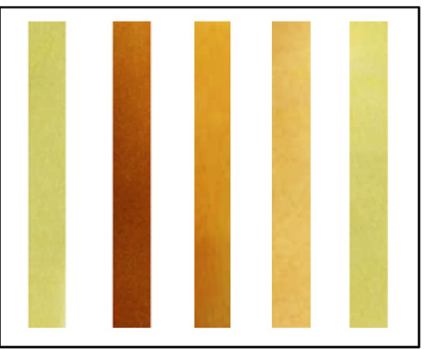
Figure 9. Color change of the test strips of L4 (1 × 10 −3 M) at various concentrations of Ni 2+ in water, from left